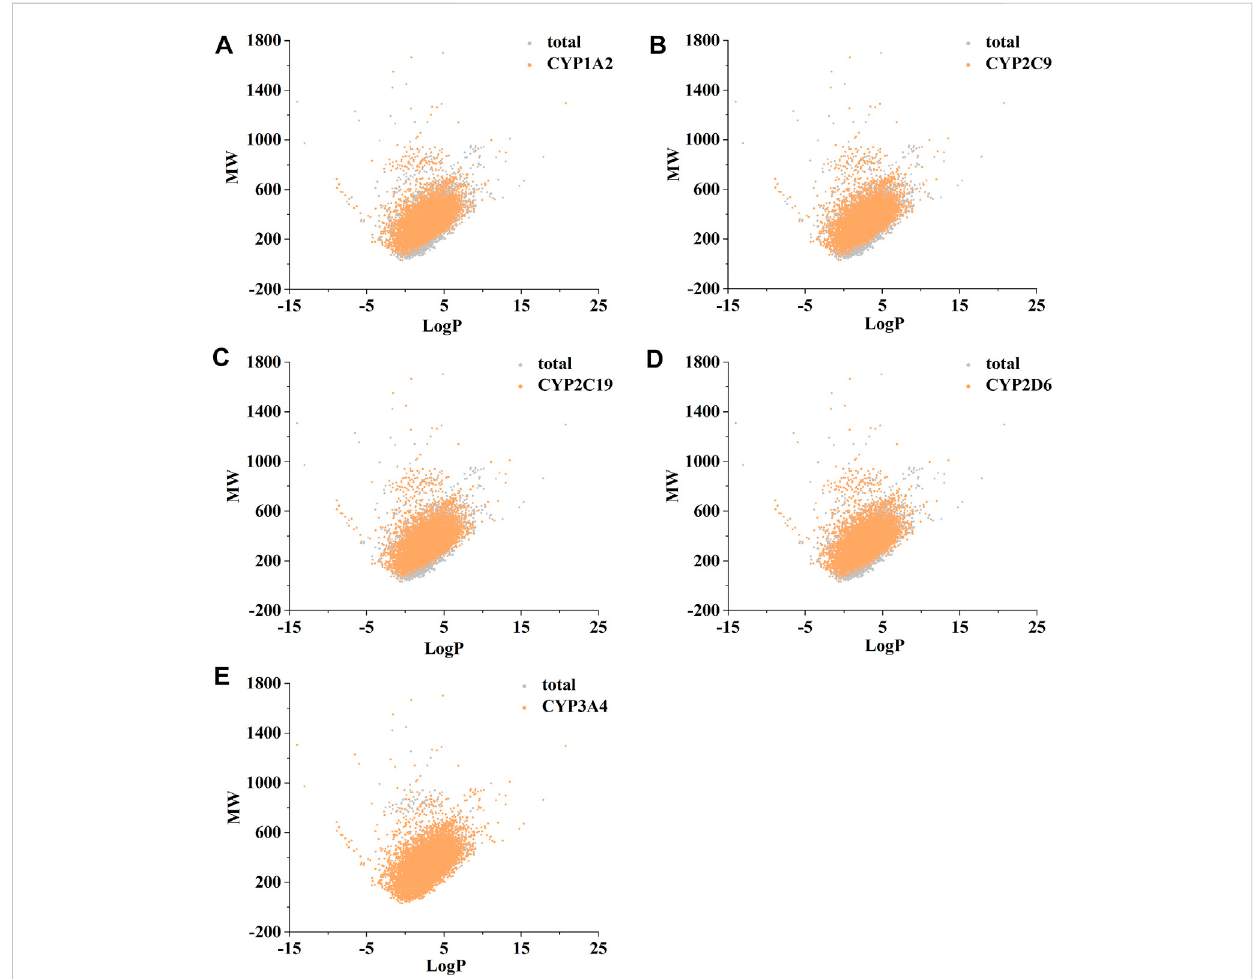
FIGURE 3 The distribution of molecular chemical space of CYP1A2 (A) , CYP2C9 (B) , CYP2C19 (C) , CYP2D6 (D) , and CYP3A4 (E) . LogP ( X-axis ) and molecular weight (MW, Y-axis ) were used to de fi ne chemical space. RDKit software was used to calculate MW and